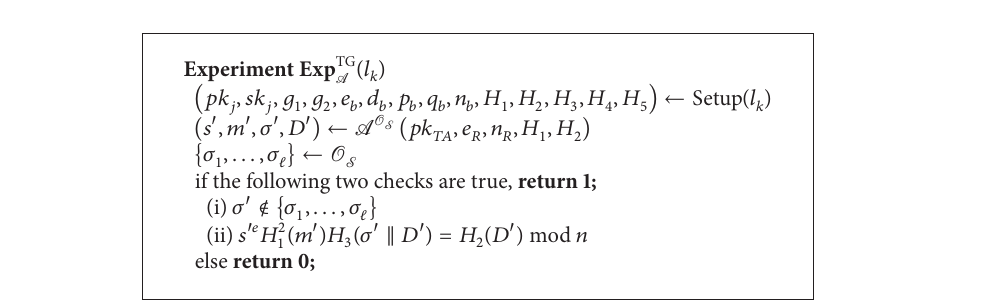
Figure 8: The proof model of